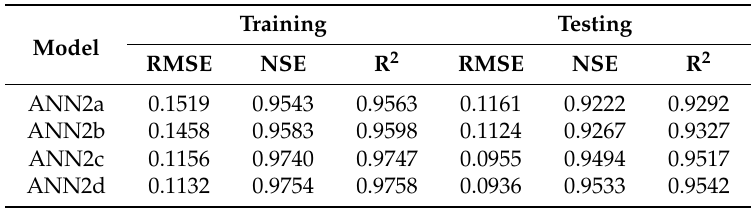
Table 6. Statistical measurement of 2 h forecasts for the entire data set.